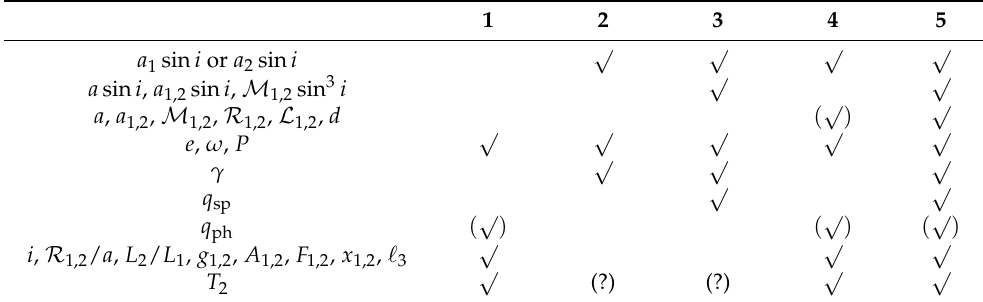
Table A1. Combinations of observables needed to derive certain parameters in favorable cases. The √ symbol indicates a sufficient combination of